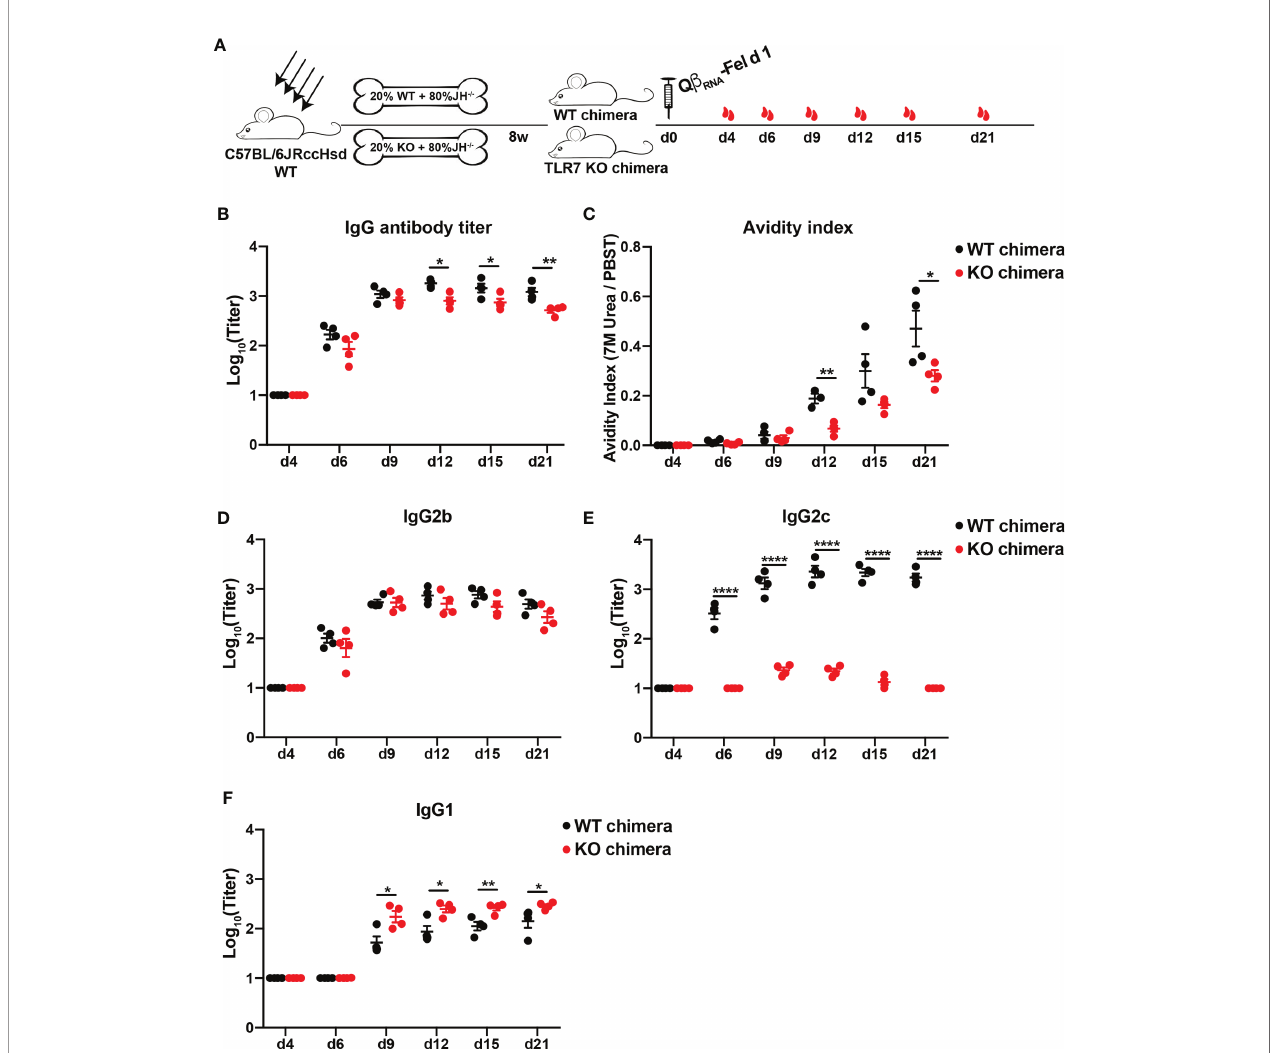
FIGURE 4 | Antibody responses of bone marrow chimeric mice against Fel d 1 after Q b RNA -Fel d 1 immunization. (A) Immunization scheme. Irradiated mice were reconstituted with 80% JH KO and 20% WT or 20% TLR7 KO BM cells. Three mice per group were injected subcutaneously with 30 m g Q b RNA -Fel d 1 at d0, and mice were bled at d4, 6, 9, 12, 15, and 21. Total Fel d 1-speci fi c IgG antibody titers (B) , avidity indexes (C) and IgG2b (D) , IgG2c (E) and IgG1 (F) antibody titers of WT and KO chimeras after Q b RNA -Fel d 1 immunization were determined by ELISA. p value from unpaired t-test was indicated as ≤ 0.05 (*), ≤ 0.01 (**), ≤ 0.0001 (****). The fi gure is representative of two independent